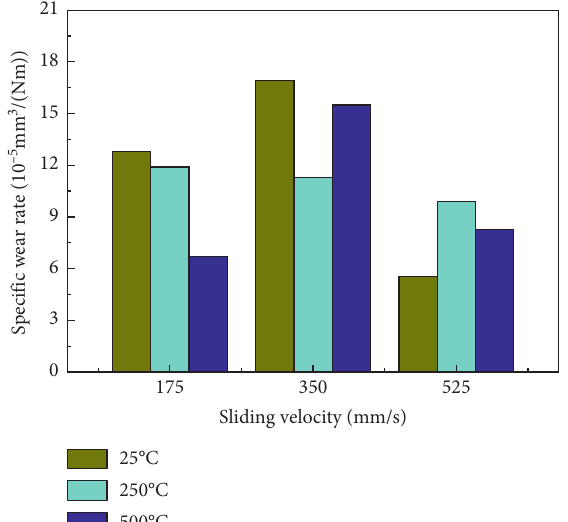
Figure 9: Effect of sliding speed on the specific wear rate of Inconel 625 by Si